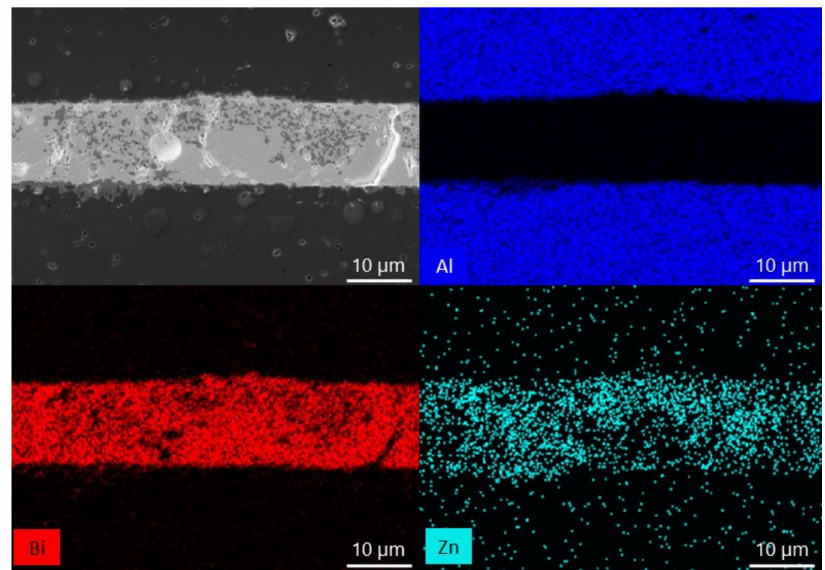
Figure 3. SEM-EDX analysis of the alumina bonded with Bi 2 O 3 -10% ZnO interlayer at 750 ◦ C.